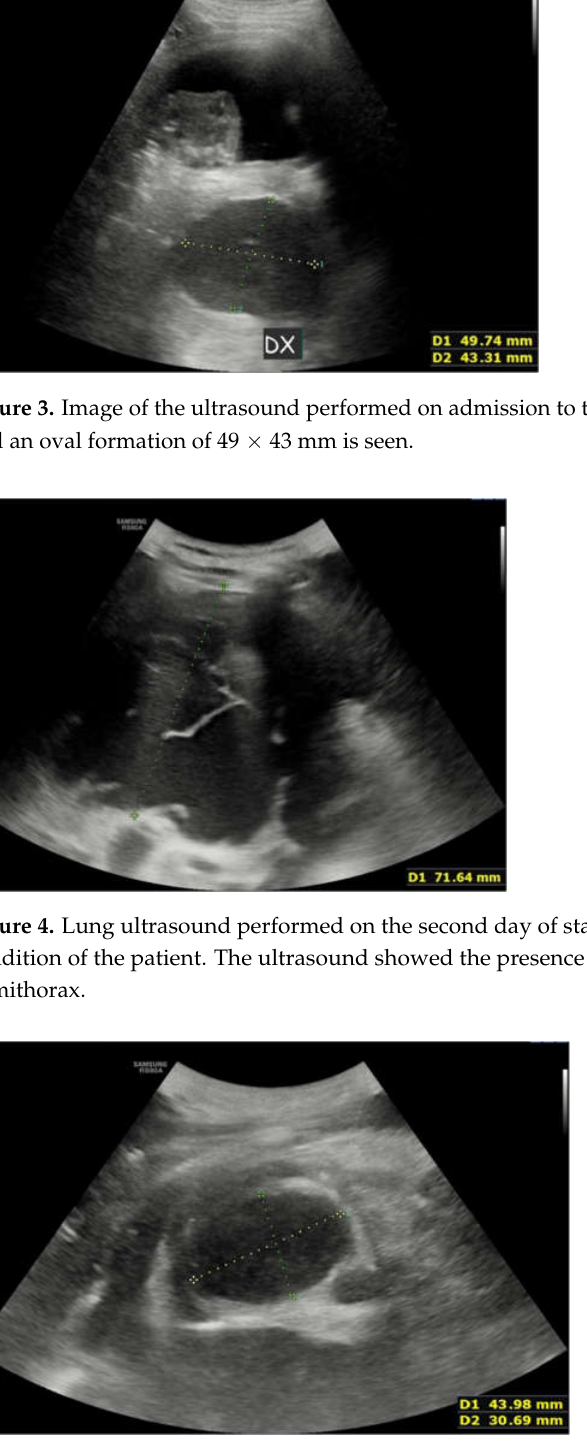
Figure 3. Image of the ultrasound performed on admission to the hospital ward. A pleural effusion and an oval formation of 49 × 43 mm is seen.